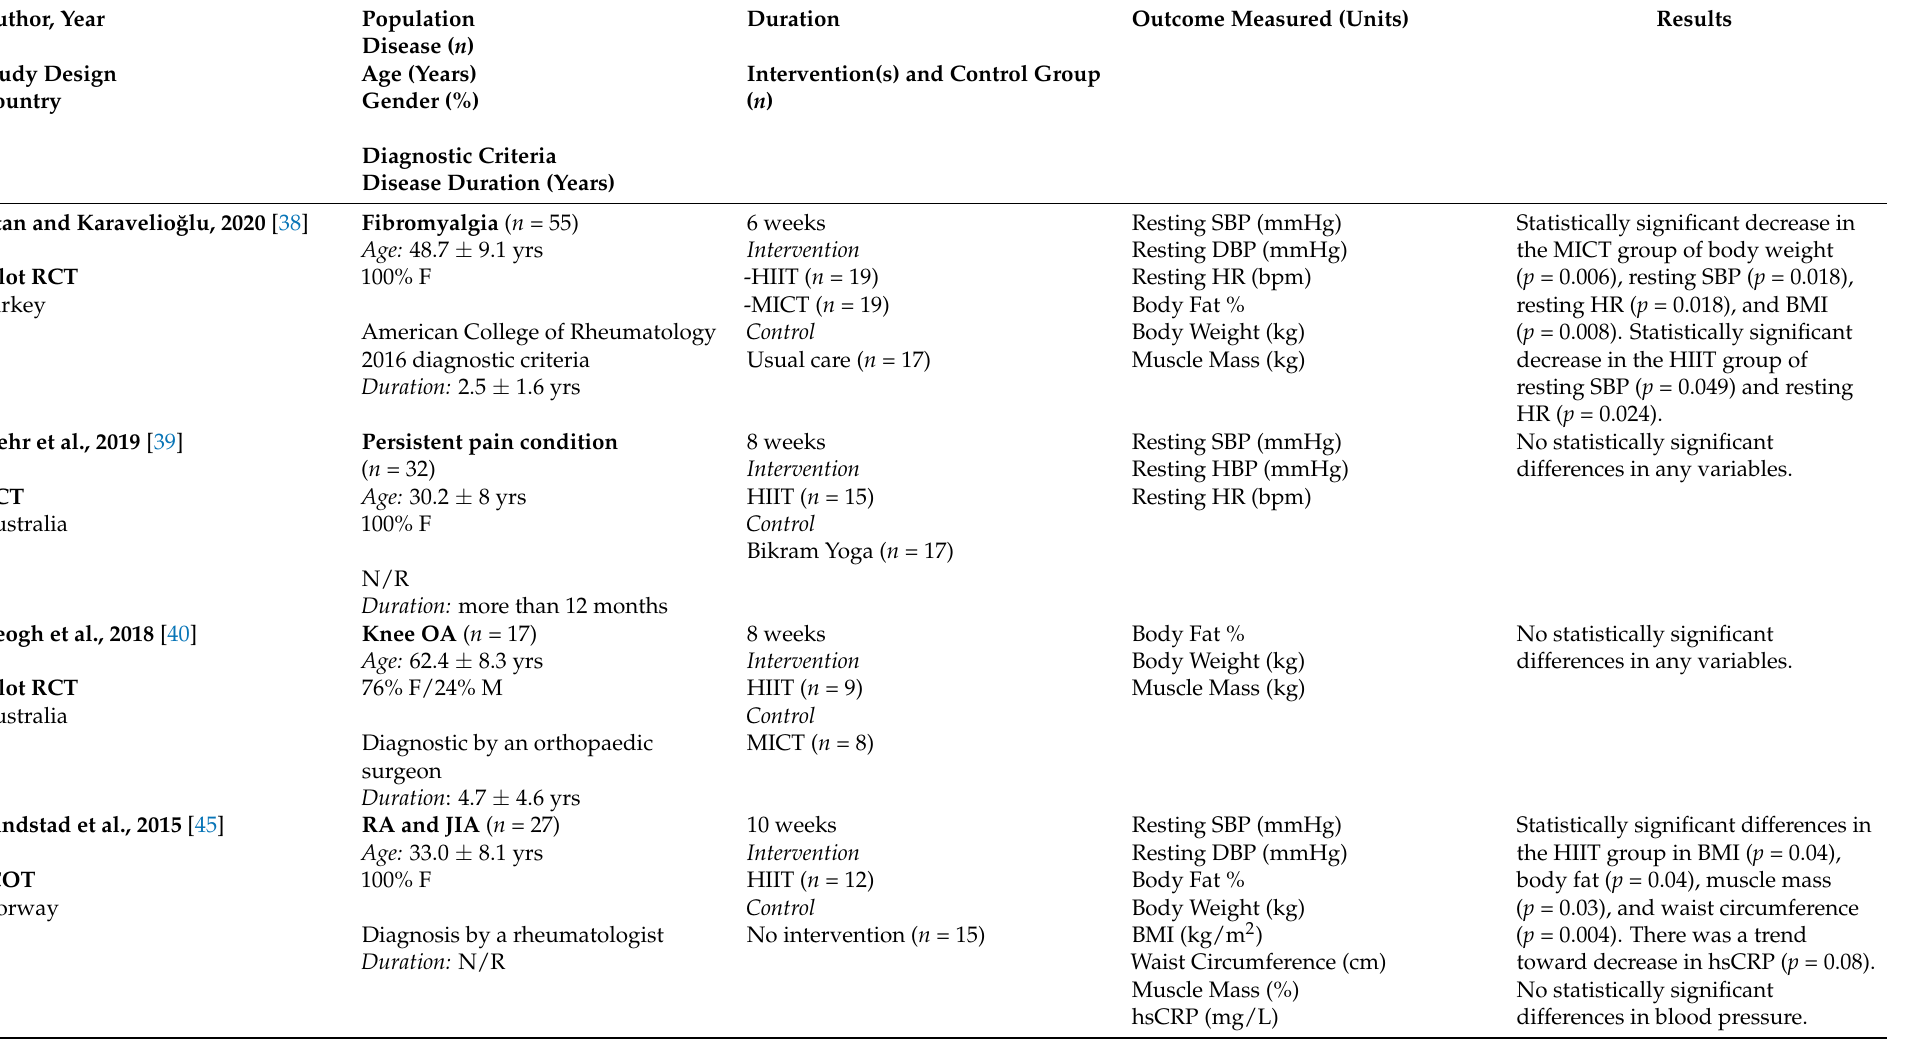
Table A1. Characteristics of the included